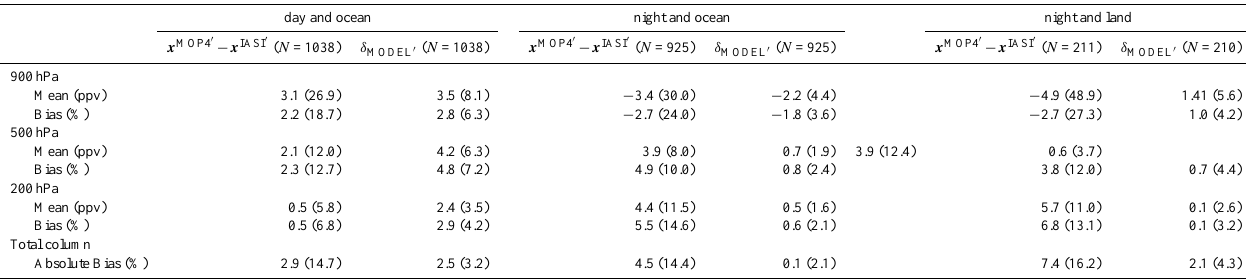
Table 4. δ x BIAS for IASI and MOPITT V4 CO retrievals for different